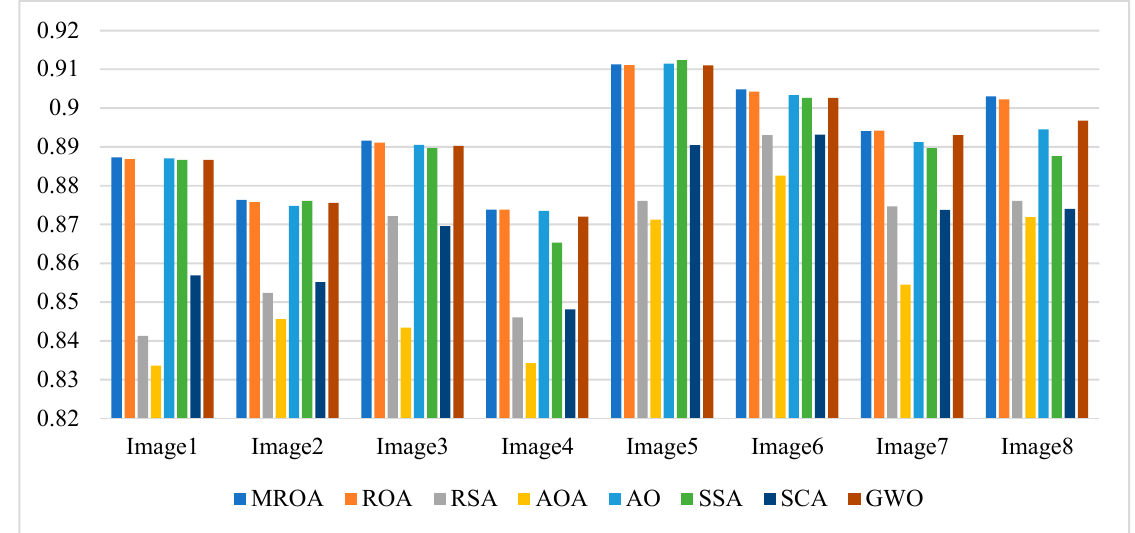
Figure 13. Average FSIM values obtained by the algorithms over all images.